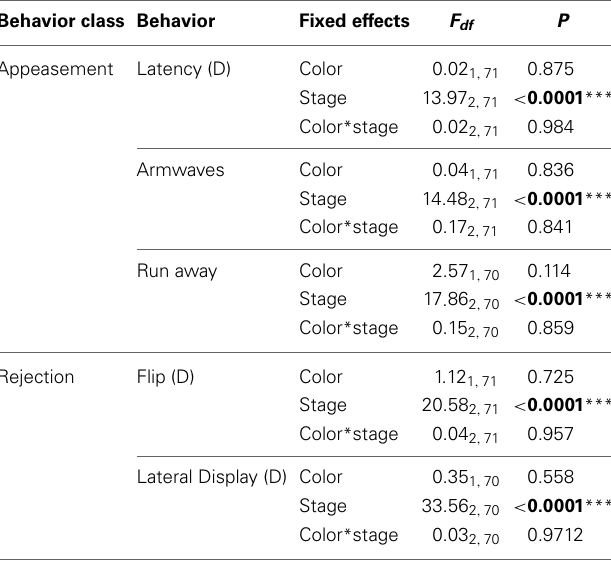
Table 2 | The effects of color, female reproductive stage and their interaction on the behaviors of female lizards.